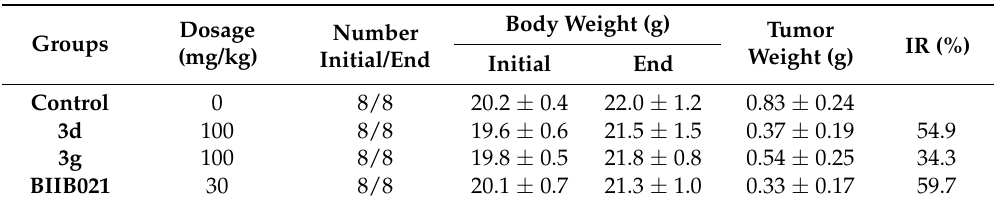
Table 4. Inhibitory effects of compounds 3d and 3g on the xenograft tumor growth of GL261 in C57 mice.